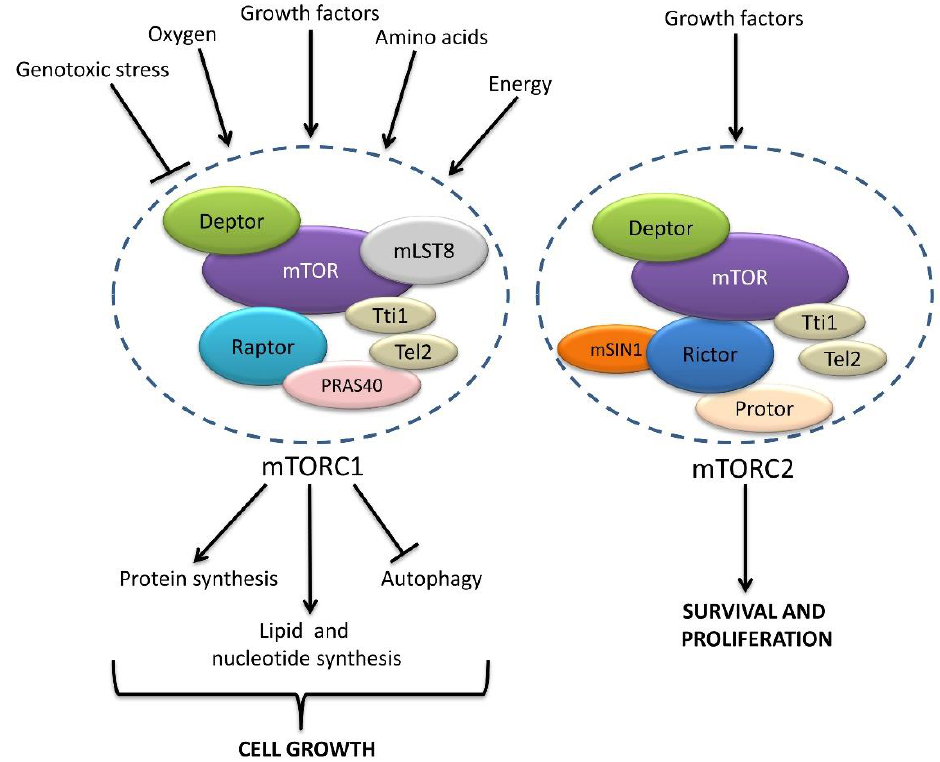
Figure 2. Schematic representation of mTORC1 and mTORC2. mTORC1 and mTORC2 share the catalytic mTOR kinase and the regulatory subunits Deptor, mLST8, and Tti/Tel2. In addition, mTORC1 consists of Raptor and PRAS40, conferring mTORC1 the ability to respond to a broad range of environmental signals, including DNA damage and growth factors, as well as oxygen, nutrient, and energy levels. mTORC1 phosphorylates multiple targets to control the balance between anabolic (leading to cell growth) and catabolic (leading to energy production) processes. The mTORC2 complex contains the subunits Rictor, Sin1, and Protor and mediates the response to growth factors, contributing to cell proliferation and survival.